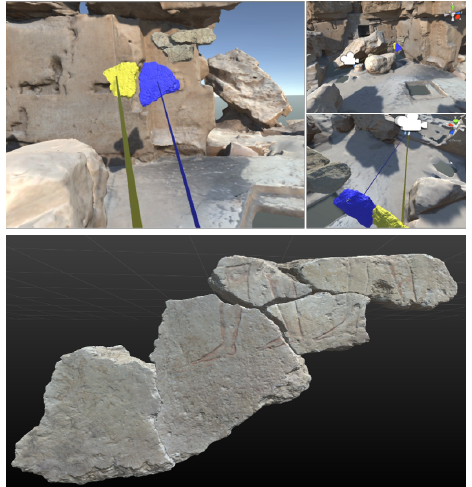
Figure 1: Example of the VR Puzzling Engine, aligning ancient decorated wall